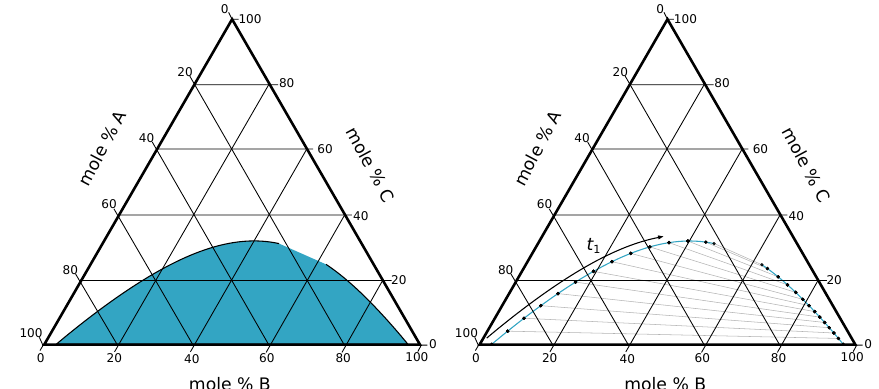
Figure 1. Sample region for liquid-liquid equilibrium (LLE) calculations of a ternary mixture, ( left ) when modeling the entire miscibility gap and ( right ) when modeling the binodal curve. The parameterization variable t 1 determines the position on the binodal curve, i.e., the pair of equilibrium compositions on the endpoints of the tie